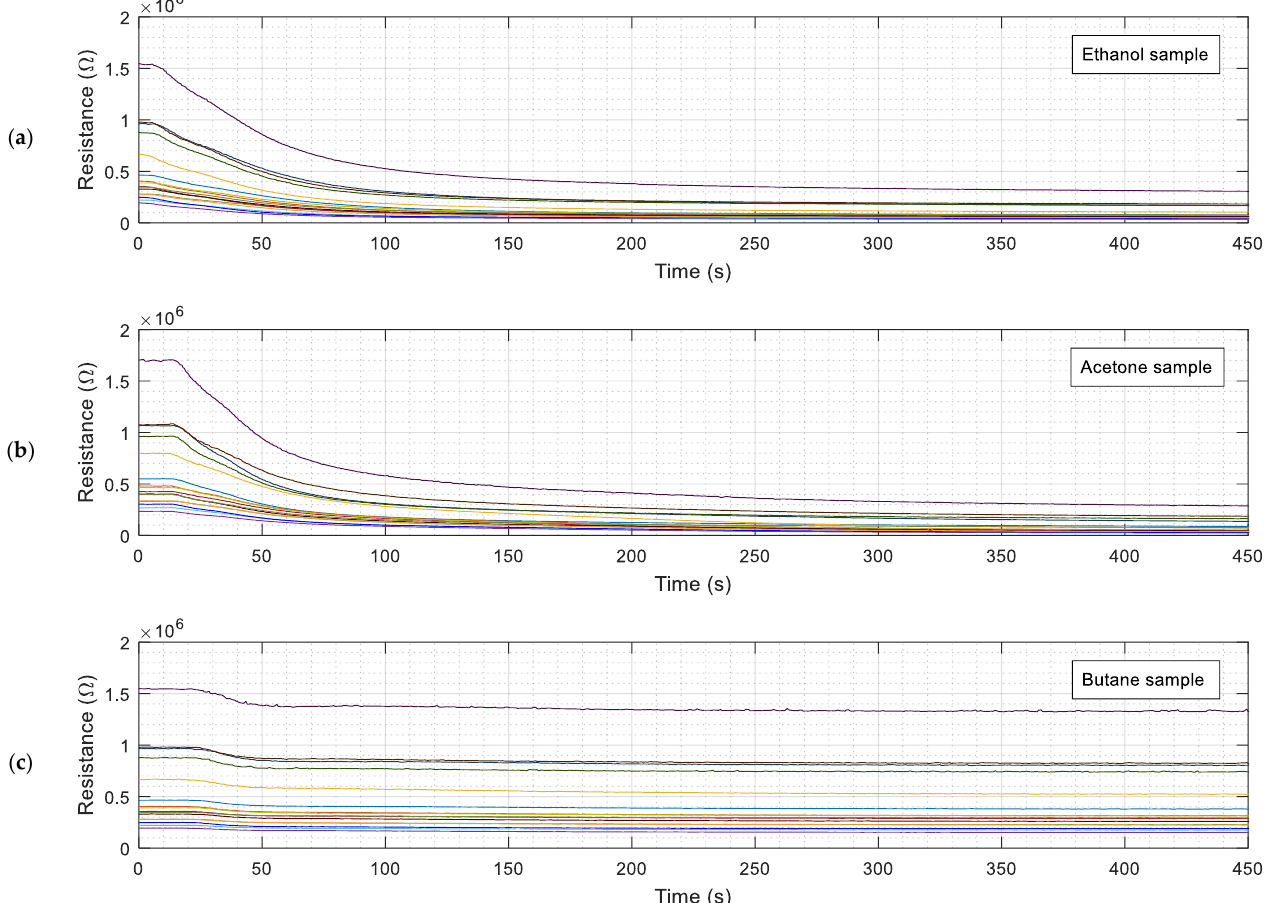
Figure 3. Evolution of the raw resistance of the sensing layer of the 16 MOX gas sensors of the eNose (each one labeled with a specific color) exposed to: ( a ) ethanol; ( b ) acetone; ( c ) butane.